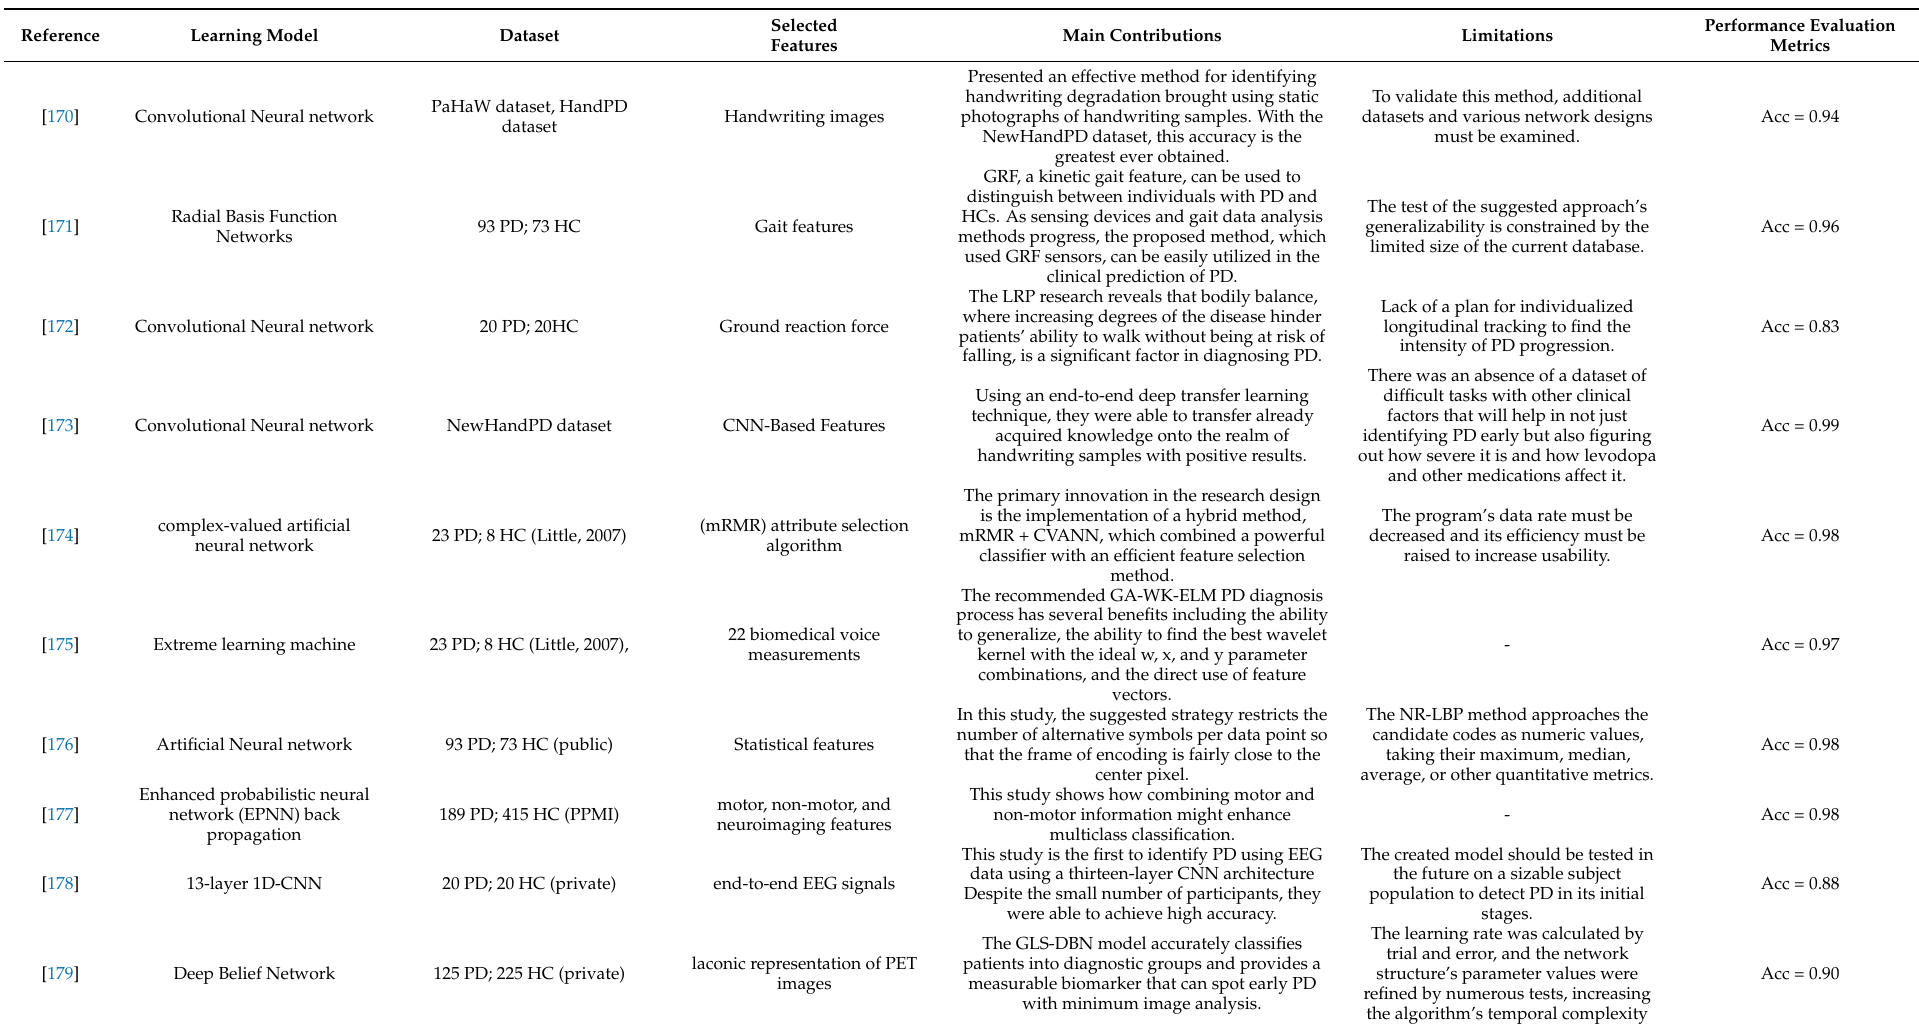
Table 6. A Summary of Studies on Deep Learning Techniques for Parkinson’s Disease